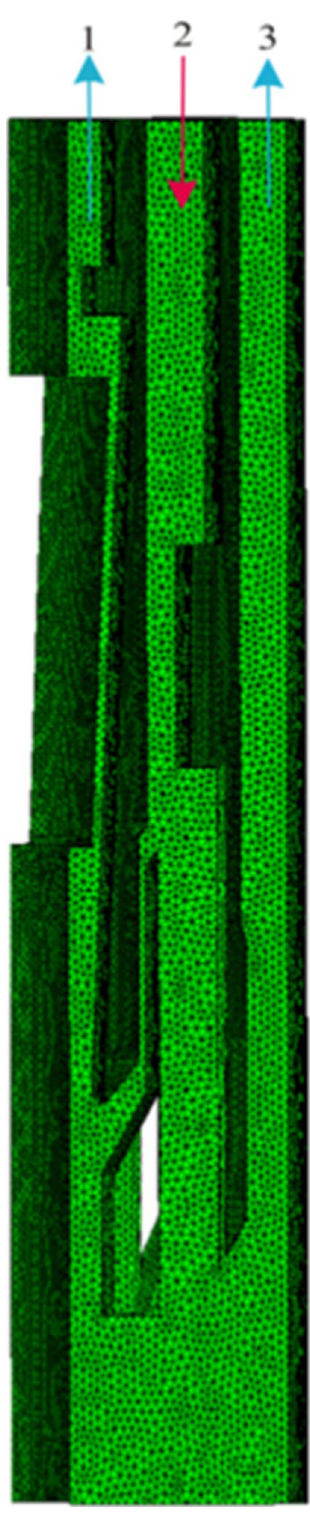
Fig. 5 Water passage mesh